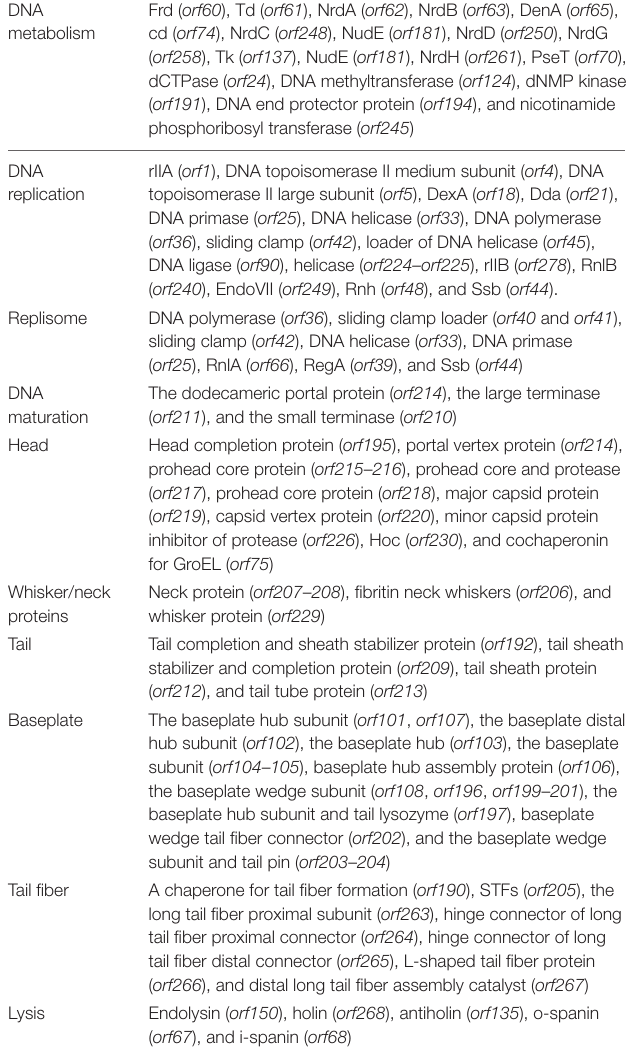
TABLE 2 | Functional categories of vB_EaeM_ ϕ Eap-3